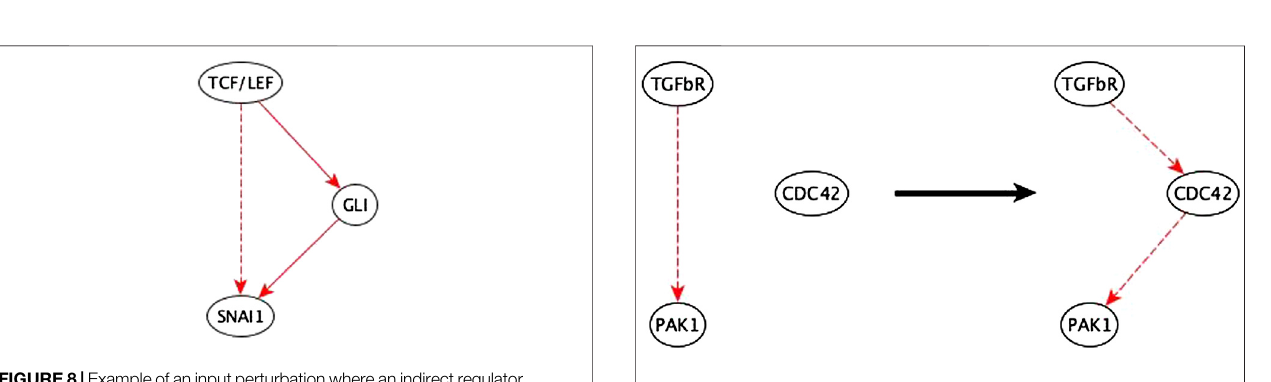
FIGURE 9 | Example of mediator node inference. The suf fi cient indirect regulationofPAK1 byTGF β RcanbemediatedbyCDC42asasuf fi cient